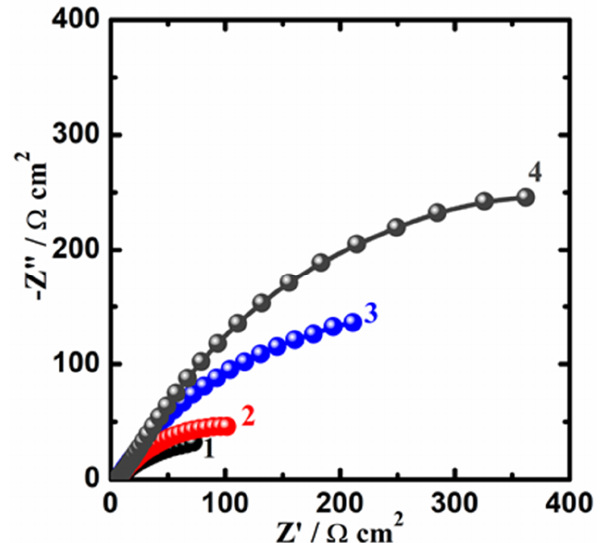
Figure 11. Nyquist plots of fabricated ODS-HECs for (1) CrFeCuMnNi; (2) CrFeCuMnNi-3 vol.% Al 2 O 3 ; (3) CrFeCuMnNi-3 vol.% Y 2 O 3 ; and (4) CrFeCuMnNi-3 vol.% TiO 2 . Al 2 O 3 ; (3) CrFeCuMnNi-3 vol.% Y 2 O 3 ; and (4) CrFeCuMnNi-3 vol.% TiO 2